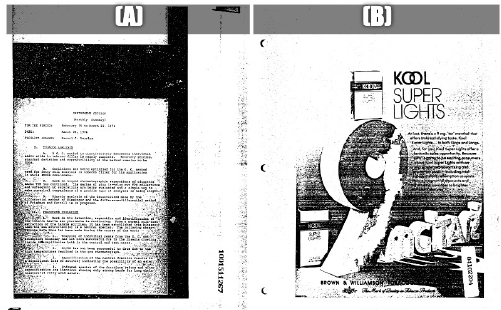
Figure 8. The image samples ( A , B ) depict the scenarios where the text is blurred or has too much noise leads OCR to extract the text incorrectly. Thus, the text contains incorrect characters or